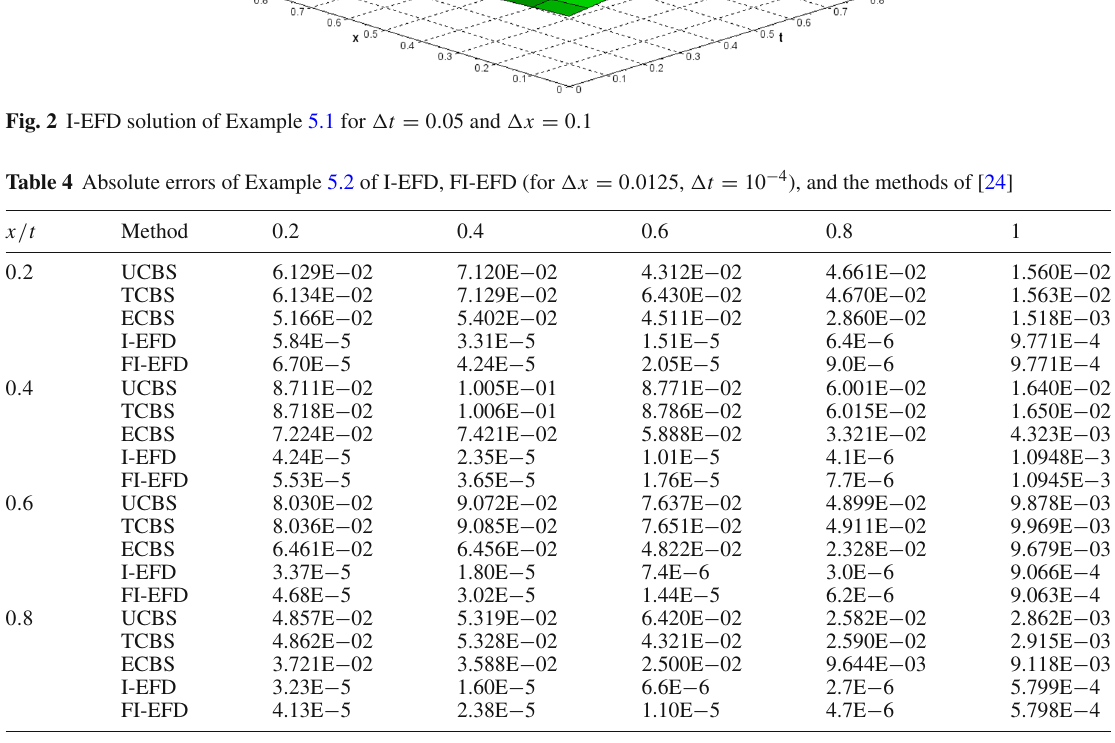
Table 5 L ∞ and L 2 errors of Example 5.2 for (cid:2) x = 0 . 05 and (cid:2) t = 10 − 3 Method I-EFD FI-EFD t Error L ∞ Error L 2 Error L ∞ Error L 2 0 .